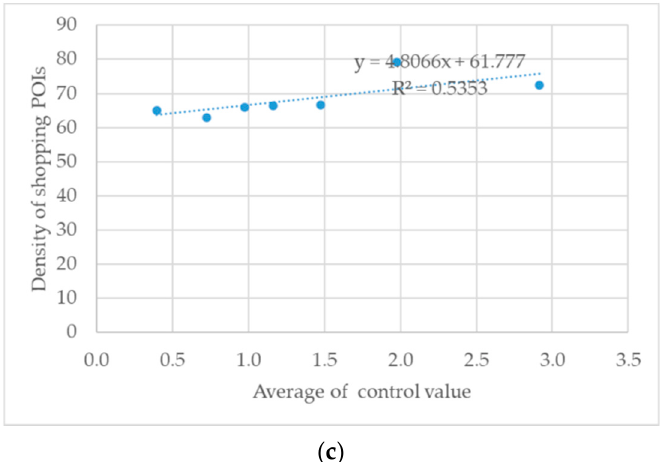
Figure 8. Scatter plot of average control value and each density of three types of POIs: ( a ) entertainment; ( b ) catering; ( c ) shopping.